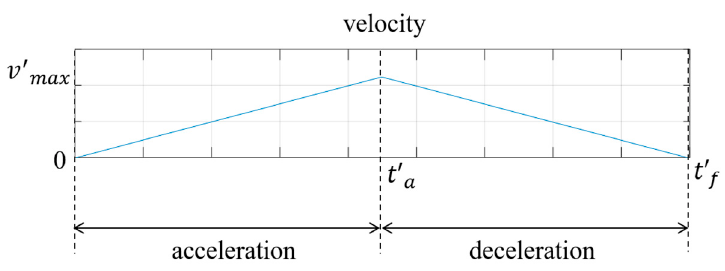
Figure 5. Short-pitch trapezoidal motion profile.